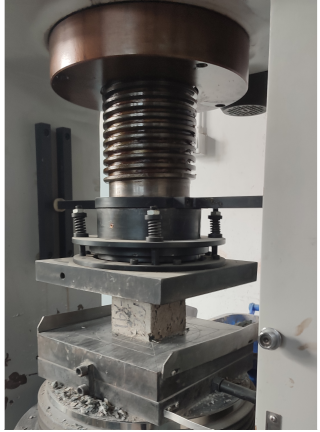
Figure 4. Compressive strength test.